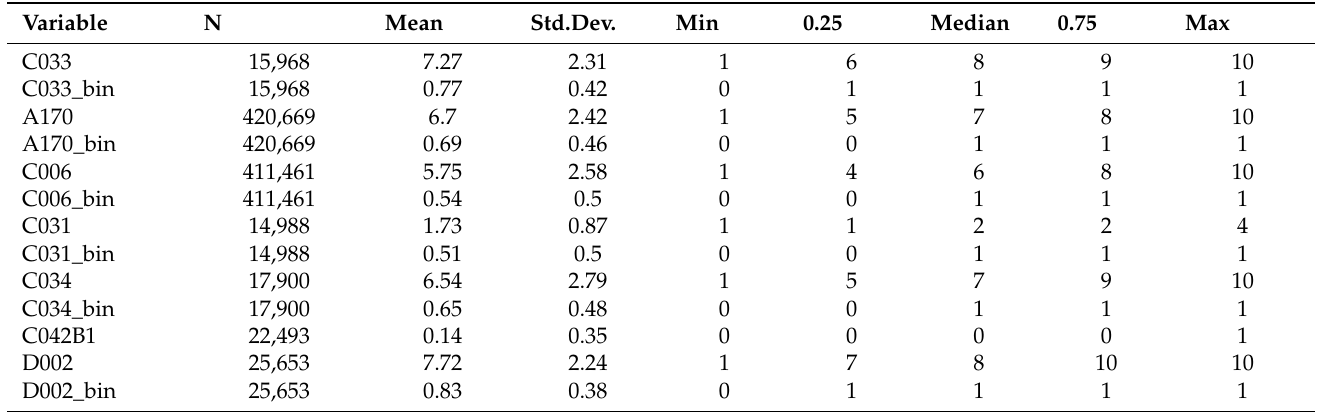
Table A2. Descriptive statistics for the World Values Survey’s variables, namely, the dependent one (two forms) and six independently selected at the end of the first two mining rounds (Figure A1, Appendix